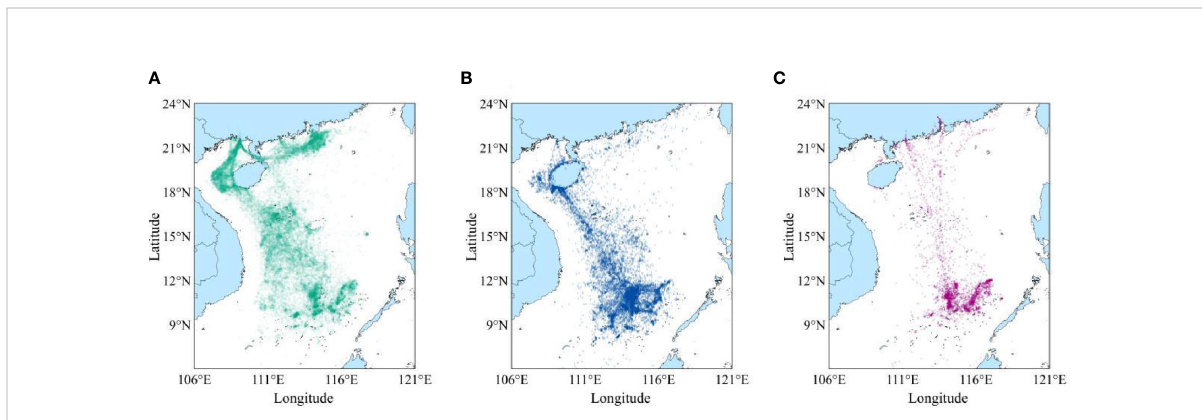
FIGURE 8 Activity of 121 large-size light falling-net vessels according to the vessel monitoring system records. Shown are the distributions of fi shing vessels from Guangxi (A) , Hainan (B) , and Guangdong (C)